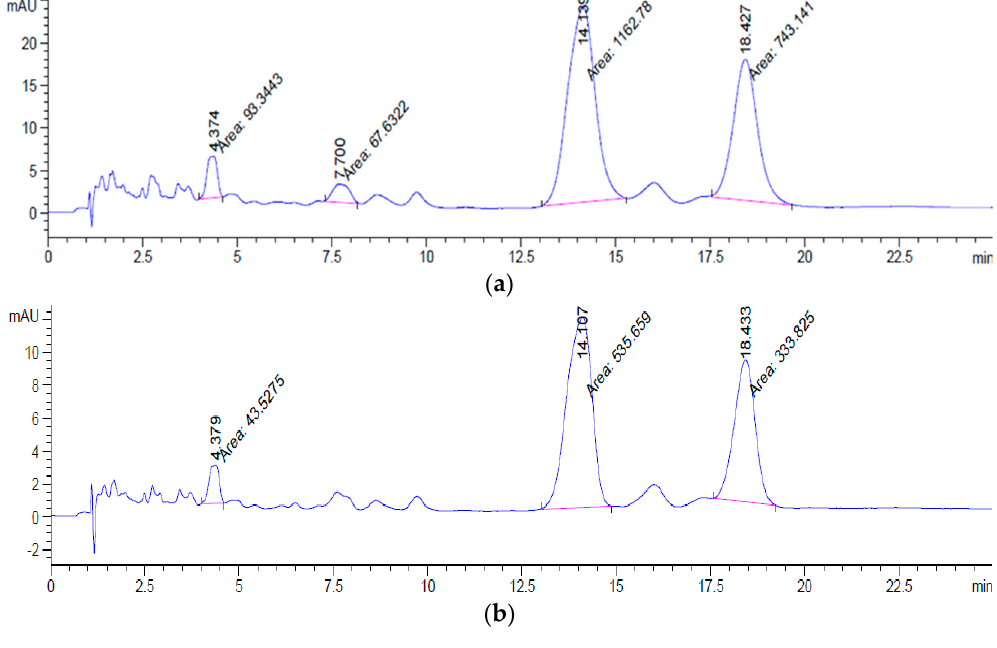
Figure 11. Effects of UV light on Δ E values of the samples including 8% gac oil-loaded SLNs, 6.5% gac oil-loaded SLNs, 5% gac oil-loaded SLNs and SLN-FREE gac oil. Figure 11 displays the trends of the color measure with regard to the UV exposure period. Accordingly, the UV exposure period had a significant effect on the color change of all the samples, which is demonstrated by the increasing Δ E trend. The gac oil-loaded SLNs experienced higher color change in comparison with other samples, indicating that SLN exhibited protective effects against oxidation degradation. 4. Conclusions The present study has shown that the encapsulation of carotenoids by SLNs using Naterol SE is feasible and practical. The suspensions containing 5% gac-oil (w/w) were dispersed in a surfactant of 5%(w/w) (Span 80:Tween 80 ratio of 28:72 w/w) and 2.5% (w/w) of Naterol SE concentration. At a hot homogenization temperature of 60 °C, hot homogenization time of 60 min and cold homogenization